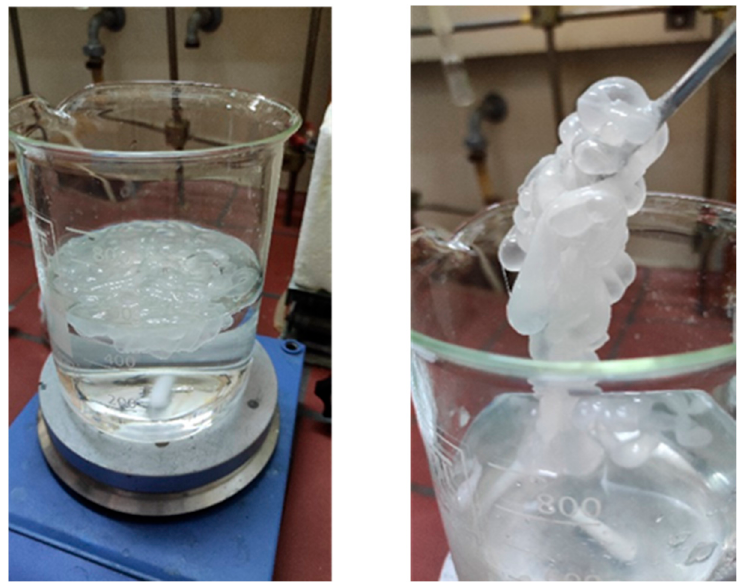
Figure 11. Images of jellification upon adding the reaction media in 1N NaOH.